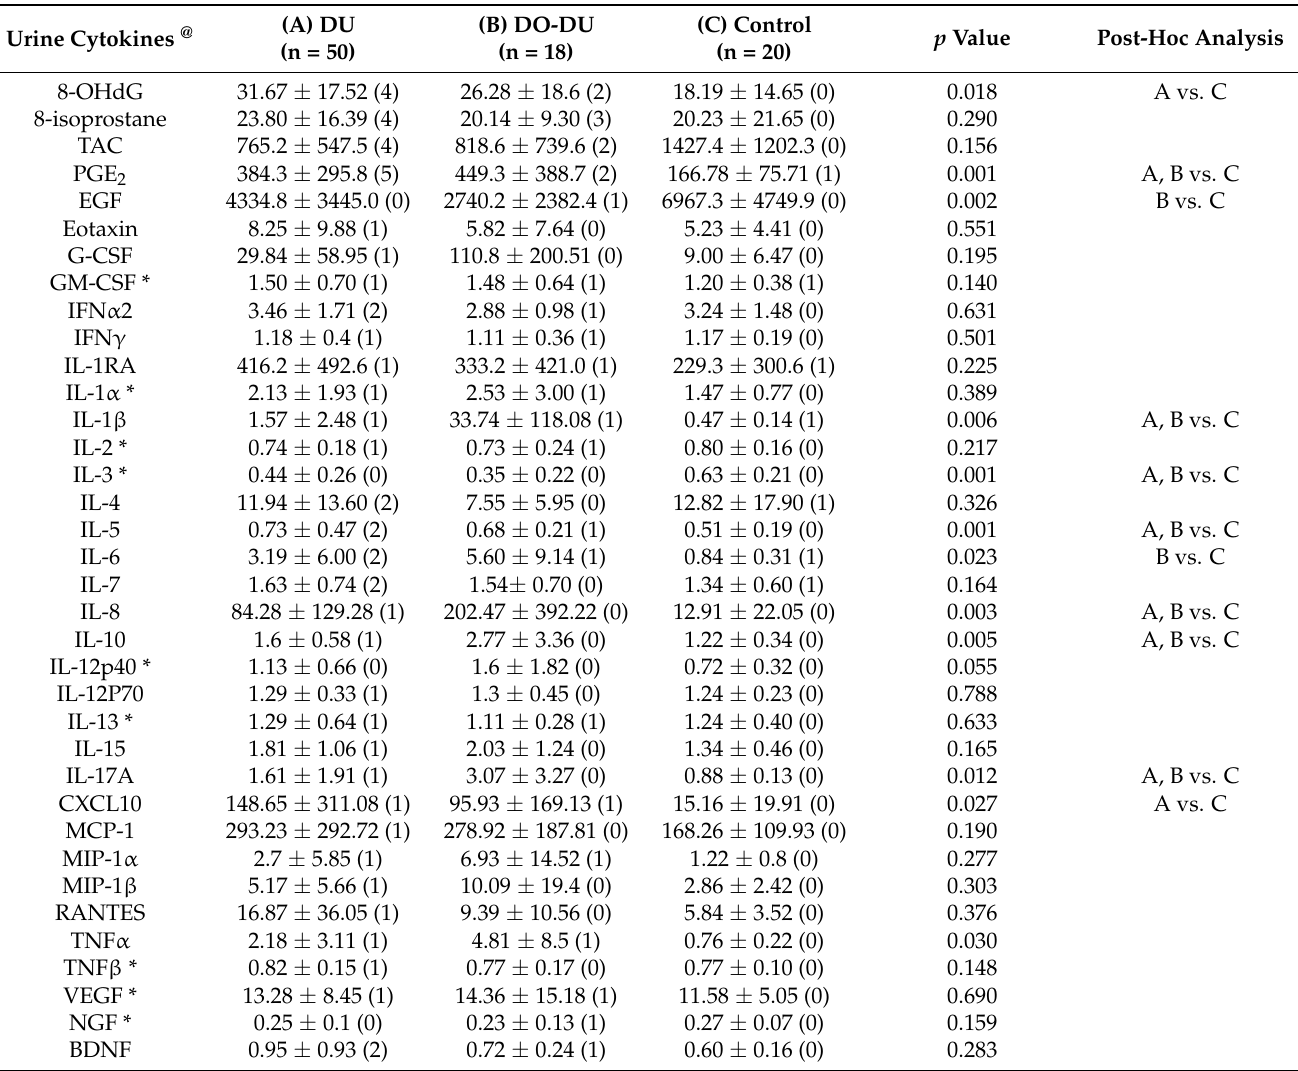
Table 2. Urine biomarker levels among DO, DO-DU patients, and